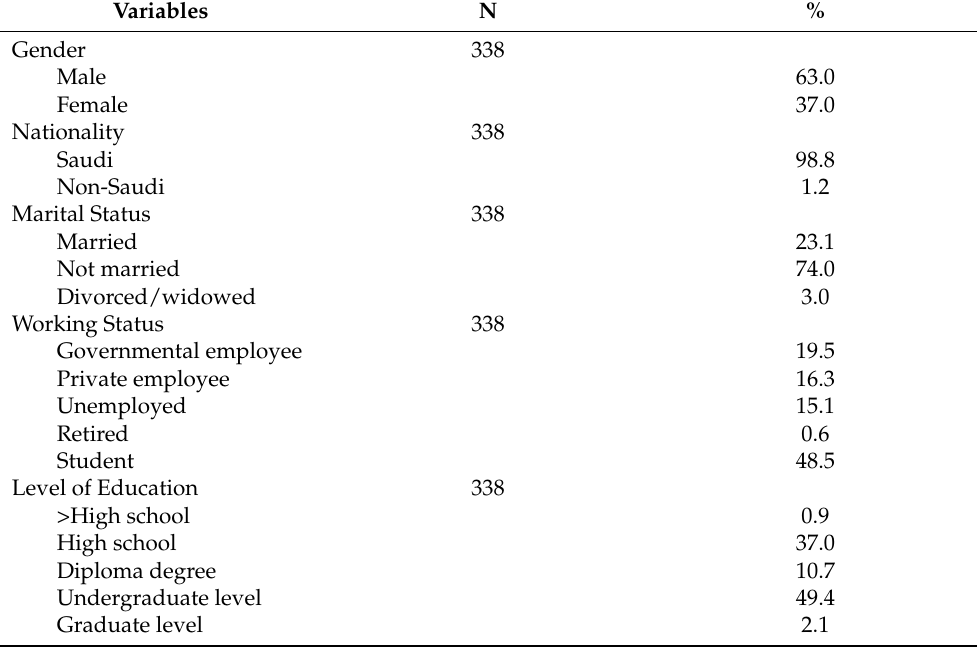
Table 1. Demographic characteristics of participants (N =